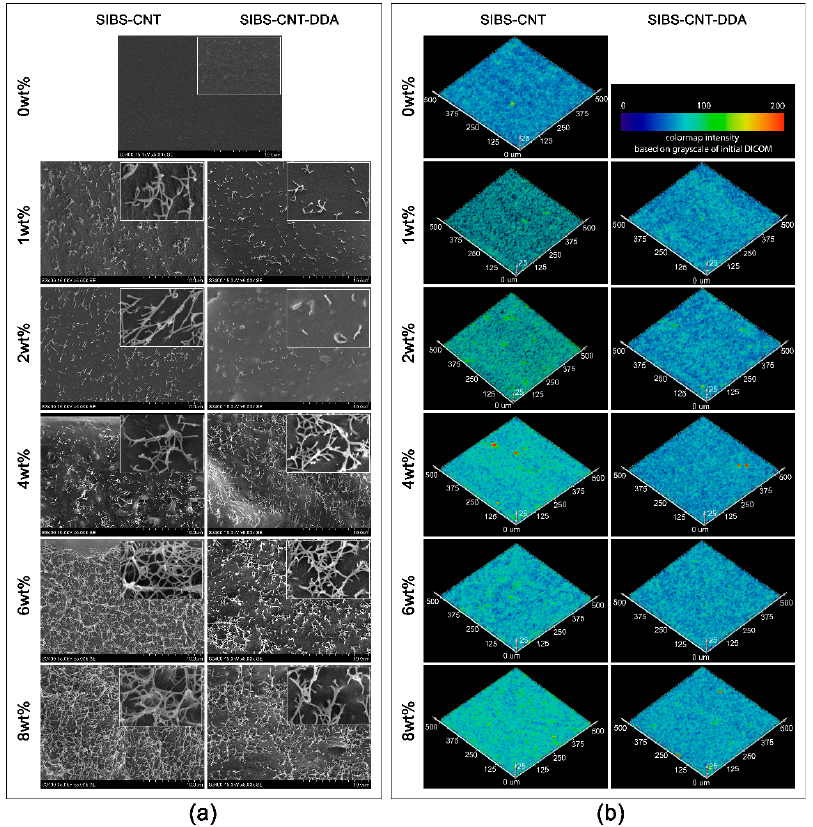
Figure 3. Visualization of the results of analysis of the structure of nanocomposites based on SIBS and carbon nanotubes: SEM images at 20,000× and 5000× magnification ( a ); 3D reconstructed images of CNT and CNT-DDA distribution in SIBS films 500 × 500 × 25 μ m 3 ( b ).